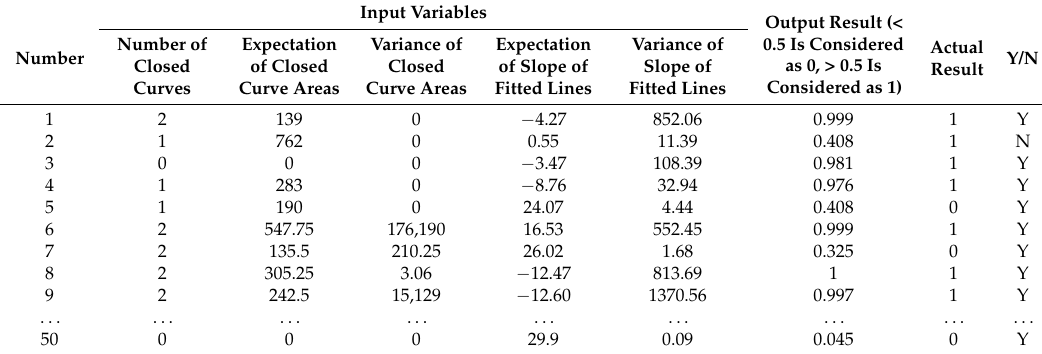
Table 4. Results predicted by the neural